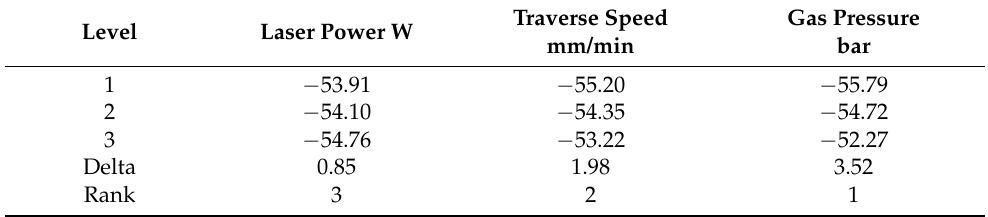
Table 8. S / N ratio smaller-is-better response table of input cutting parameters of 4 mm thick SPF-UPE.